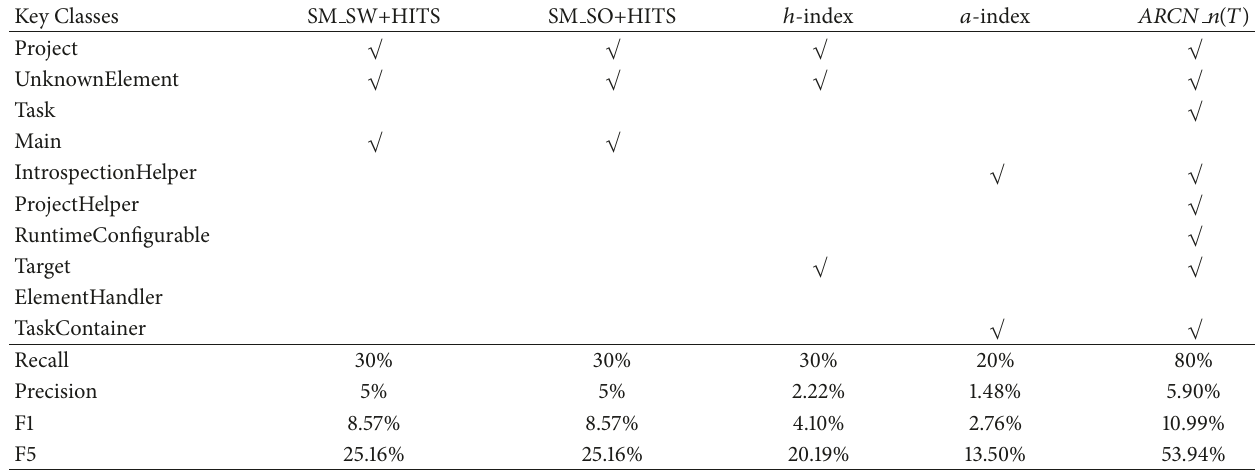
Table 6: Comparison of the results obtained by the approaches applied to ant.